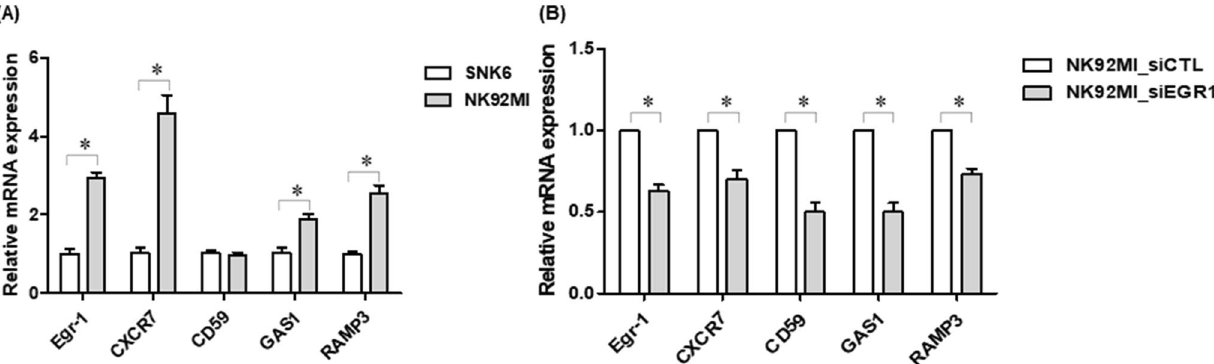
Figure 5. mRNA expression of EGR-1, CD59, CXCR7, GAS1 and RAMP3 was determined using qRT- PCR relative to levels in SNK6 using △△ Ct method in NK/T lymphoma cell lines ( A ). NK92MI cells were transfected with siRNA control and siEGR-1. mRNA expression of EGR-1, CD59, CXCR7, GAS1 and RAMP3 was detected using qRT-PCR ( B ). P values were determined using Student’s t-test. * P < 0.05 versus siCTL. qRT- PCR, quantitative reverse transcription polymerase chain reaction; siRNA, small interfering